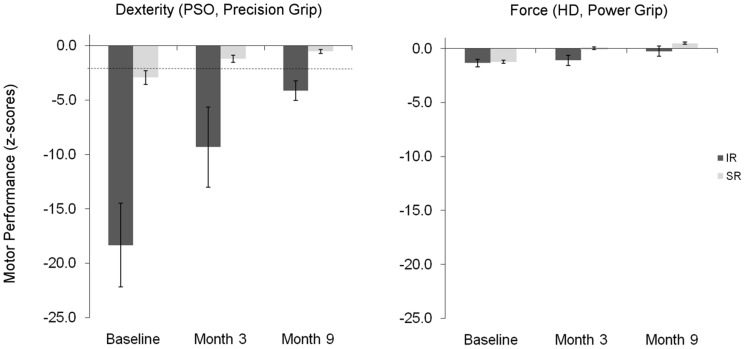
Time course of motor hand function in impaired (IR) and successful recovery (SR) subgroups.Left panel shows the recovery of dexterity, as measured with the picking small objects (PSO) task. The right panel shows the recovery of grip force, as measured with hand dynamometry (HD). Motor performance (y-axis) is given in z-scores task compared to healthy controls (lower scores indicate worse motor performance). Dashed line indicate thresholds for z = −2.5 (p<.01).